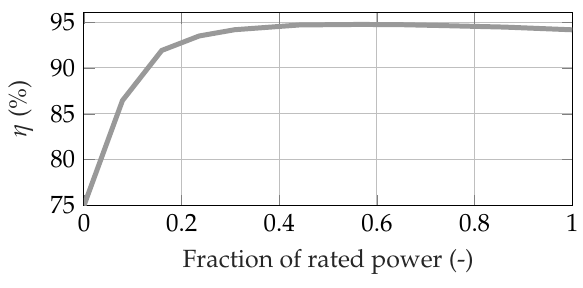
Figure 5. Efficiency of the DC/DC